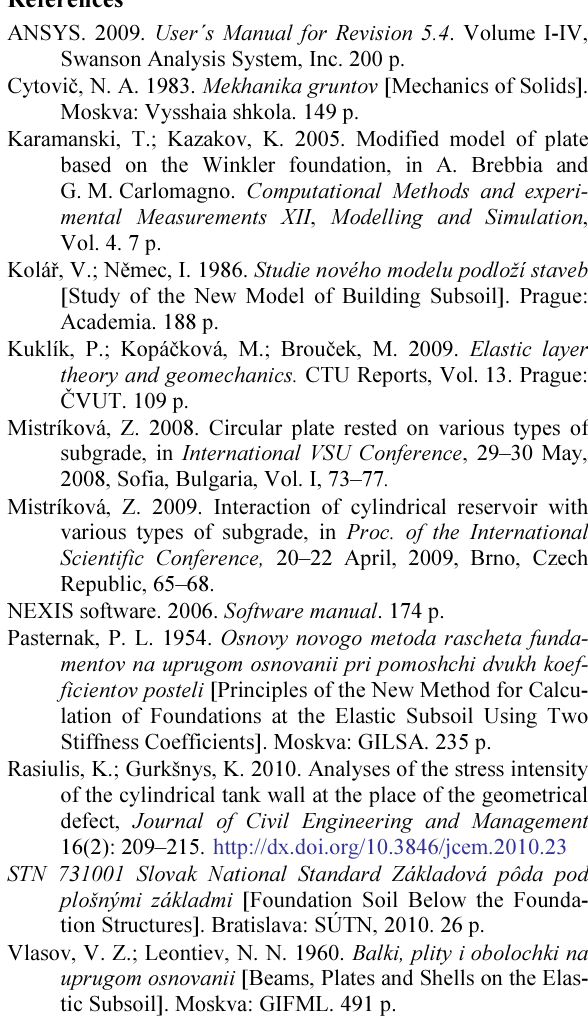
Table 2. Comparison of the results of the calculation with the experimentally obtained values Silo 1